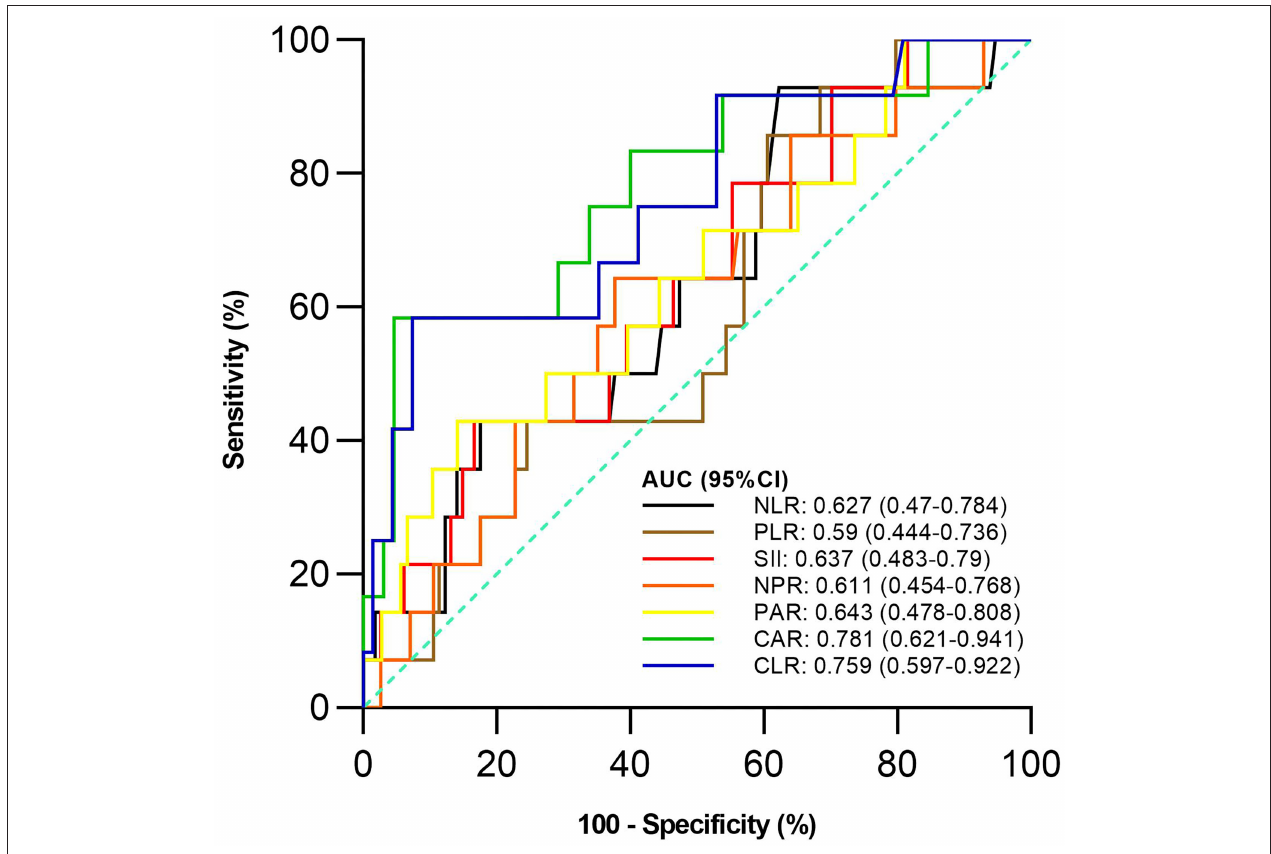
FIGURE 4 | Comparison of the predictive performance of inflammatory indexes for non-response to 5-aminosalicylic acid (5-ASA). 5-ASA, 5-aminosalicylic acid; AUC, Area under the curve; CI, Confidence interval; NLR, Neutrophil-to-lymphocyte ratio; PLR, Platelet-to-lymphocyte ratio; SII, Systemic immune-inflammation index; NPR, Neutrophil-to-platelet ratio; PAR, Platelet-to-albumin ratio; CAR, C-reactive protein-to-albumin ratio; CLR, C-reactive protein-to-lymphocyte